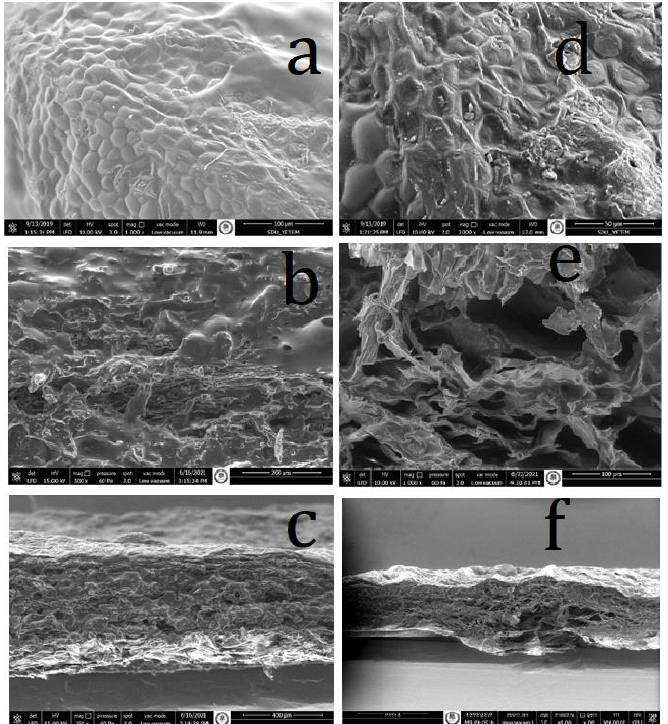
Figure 7. SEM image of samples dried with and without CM application. ( a ): control exterior section (100 µm), ( b ): control interior section (200 µm), ( c ): control cross section (400 µm), ( d ): optimum CM exterior section (50 µm), ( e ): optimum CM interior section (100 µm), ( f ): optimum CM cross section (1 mm).